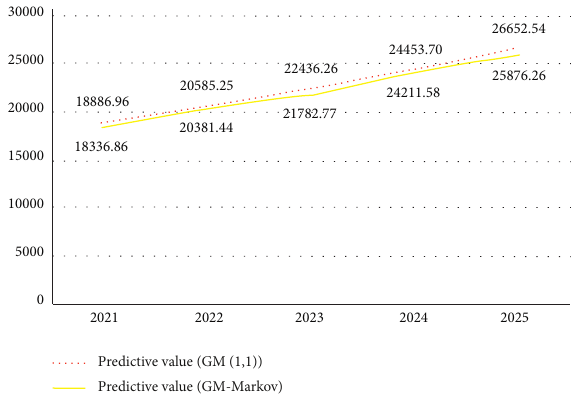
Figure 6: Predictive value comparison between GM (1,1) model and GM-Markov model.